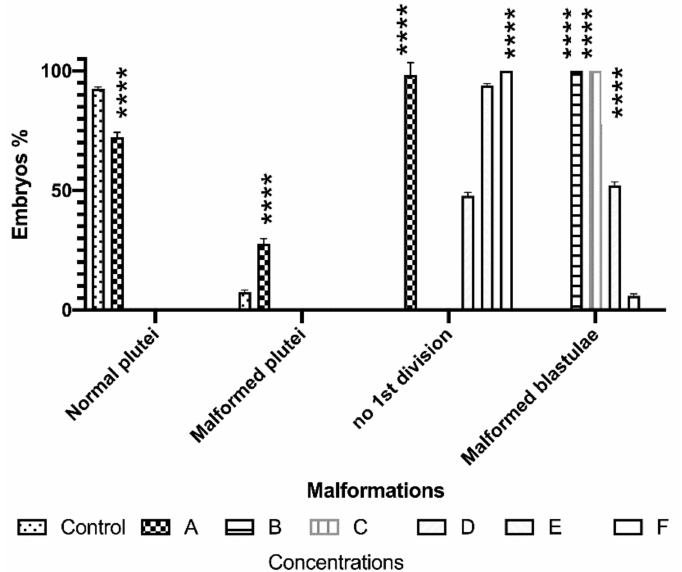
Figure 4. P. lividus exposed to Cu. Percentage of normal plutei, malformed, plutei, and eggs with arrest of the first mitotic division. Malformed blastulae were produced when newly fertilized eggs were exposed to Cu at the six concentrations tested (A, 0.01; B, 0.05; C, 0.1; D, 0.3; E, 1.0; and F, 5.0 mg/L) in comparison to controls, represented by newly fertilized eggs tested in FSW. The statistical significance of differences between test groups and controls is reported as follows: **** p < 0.0001).